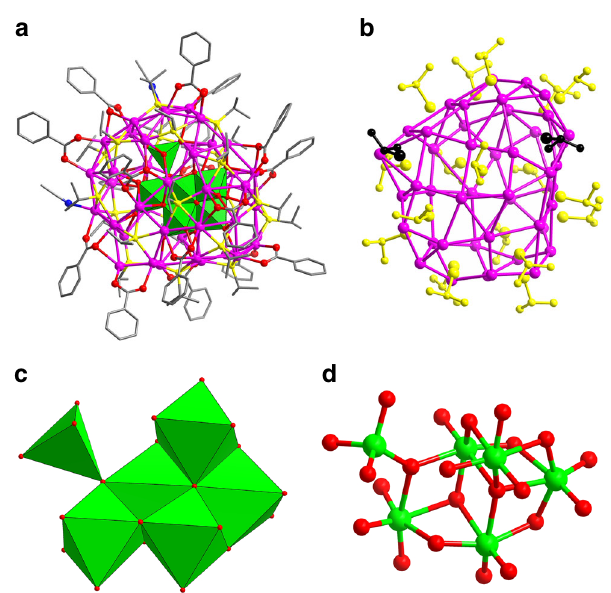
Fig. 2 Single-crystal X-ray structure of SD/Ag44 . a The molecular structure of SD/Ag44 . The inner POM anion template is shown in polyhedral mode (Color legend: Ag: purple; S: yellow; Mo: green; O: red; C: gray; N: blue). b The distributions of i PrS − ligands on the Ag 44 shell sorted by different coordination modes individually colored. Black: μ 3 and yellow: μ 4 . The polyhedral ( c ) and ball-and-stick ( d ) modes showing the inner Mo 6 O 22 8 −